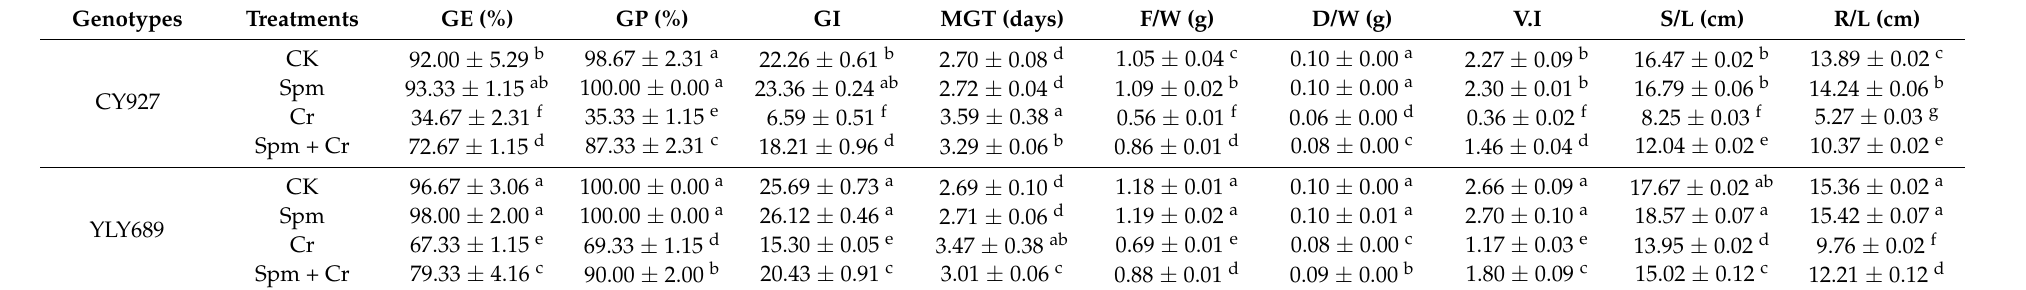
Table 1. Effects of seed priming with SPM on germination energy (GE), germination percentage (GP), germination index (GI), mean germination time (MGT),